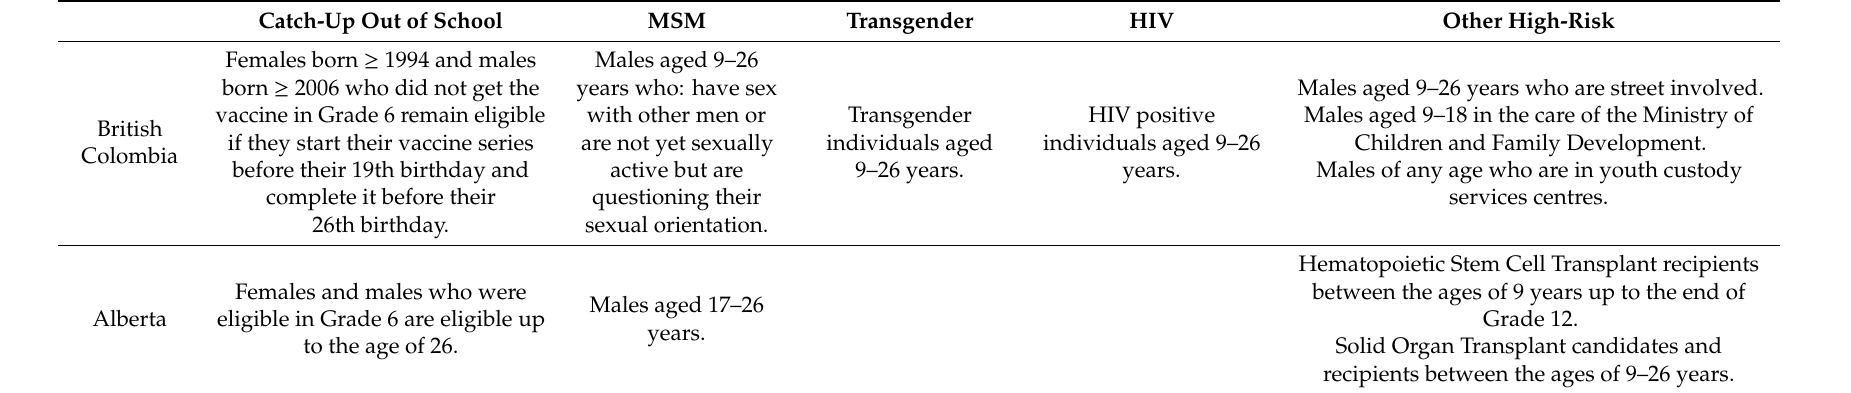
Table 4. Other groups eligible for public HPV vaccination